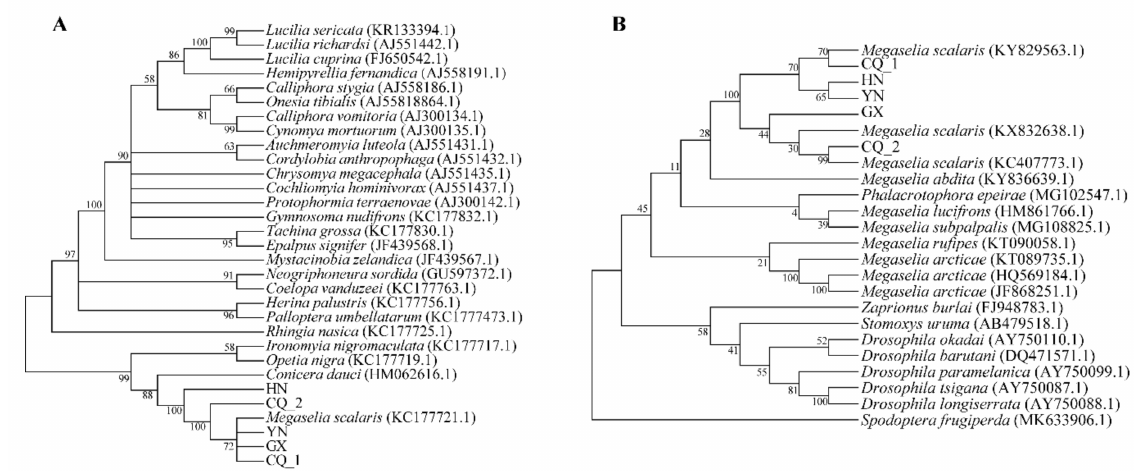
Figure 4. Phylogenetic tree of two DNA barcode sequences (( A ) 28S rRNA, ( B ) CO I) of five M. scalaris specimens and comparative